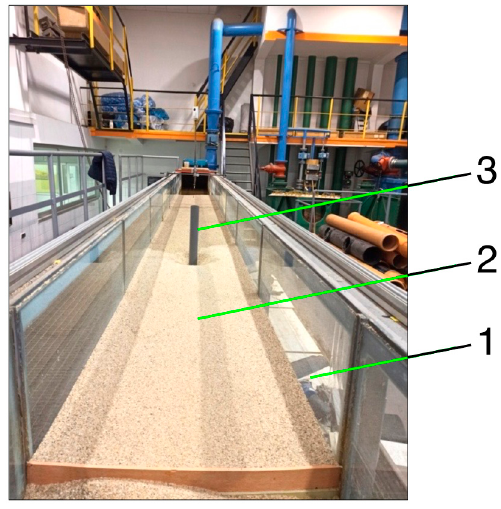
Figure 3. Laboratory flume—view from downstream: 1—tilting glass flume, 2—erodible bed, 3— bridge pier model.